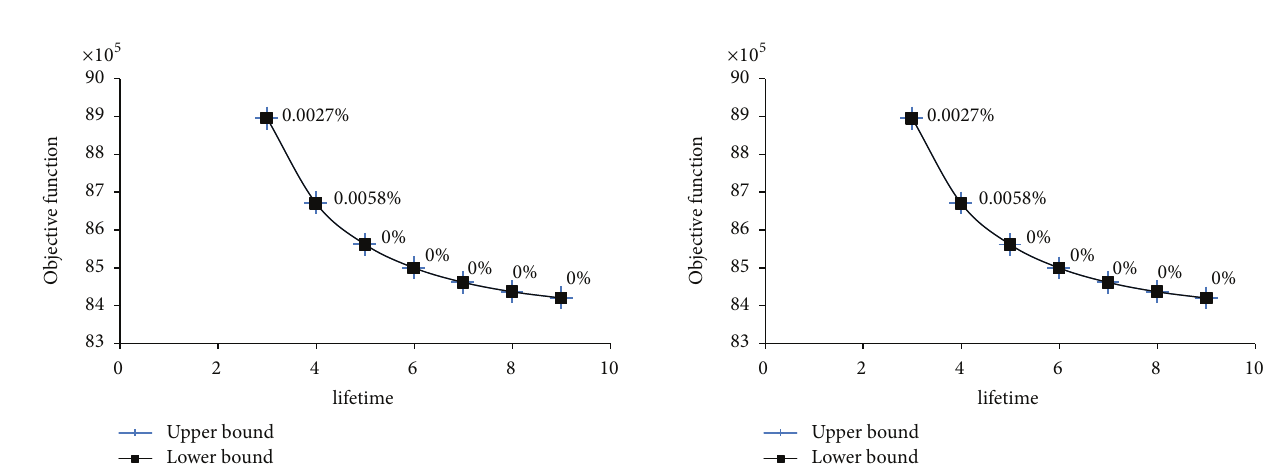
Figure 5: Sensitivity of objective function to changes in the lifetime for 49-node data set.